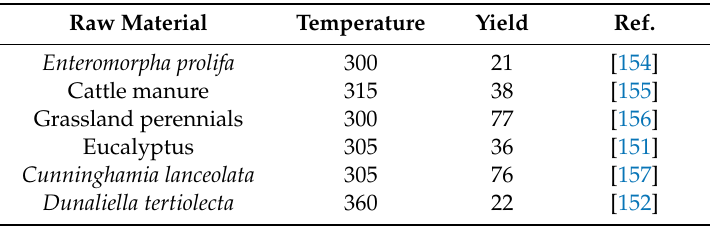
Table 5. Reaction temperatures via hydrothermal liquefaction for some biomasses. Raw Material Temperature Yield